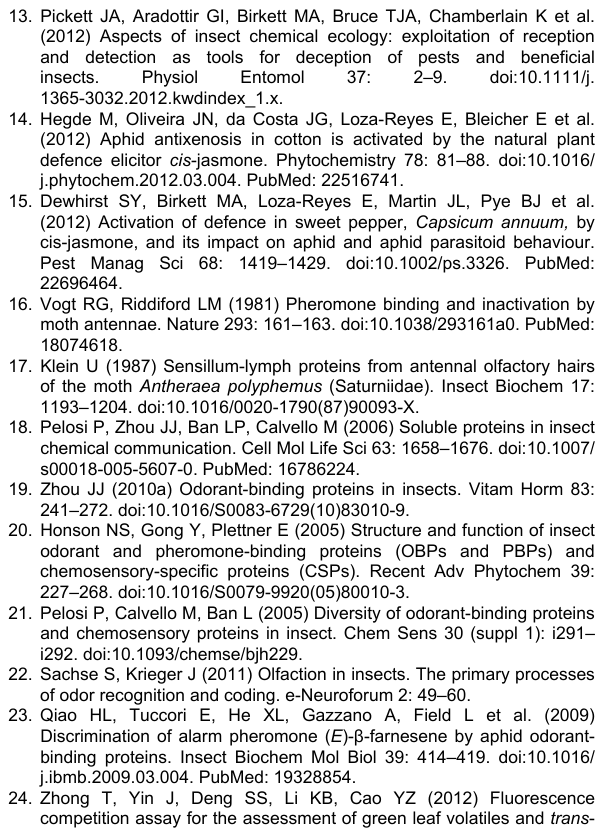
Figure S2. Alignment of the A. gossypii CSPs. Full-length amino acid sequences of AgosCSPs were aligned by ClustalX